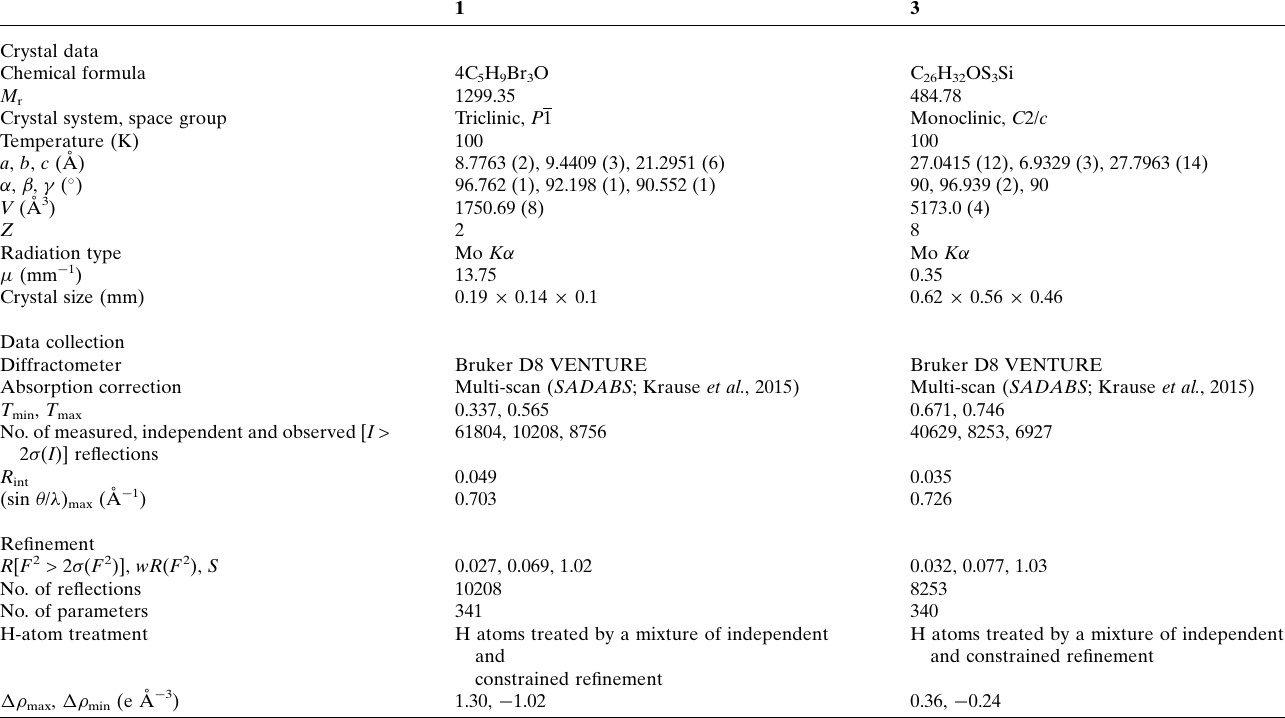
Table 4 Experimental